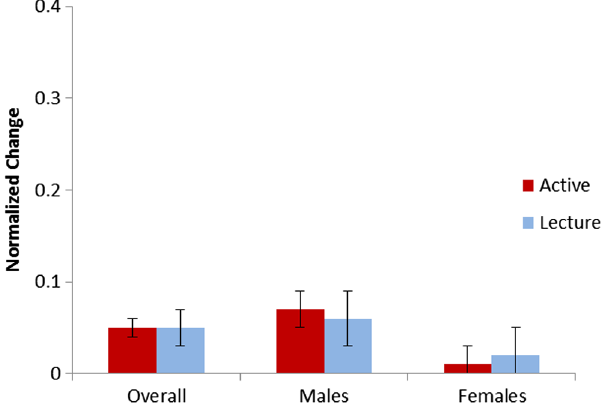
FIG. 4. Normalized change on the BEMA across the Spring semester for students in Active Physics and traditional-lecture physics. Error bars represent the standard error of the mean. Significance tests were not conducted separately within each gender because the gender × instruction-type interaction effect was not significant.